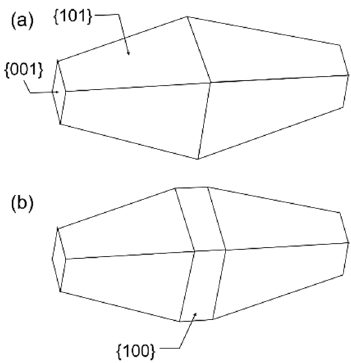
Figure 1. ( a ) TiO 2 (anatase) nanoparticles as tetragonal bipyramids with height equivalent {101} faces. The truncation at the top of each pyramid gives rise to the formation of the {001} faces, ( b ) TiO 2 (anatase) tetragonal bipyramids with height equivalent {101} faces and four {100} faces on the edge of square base.